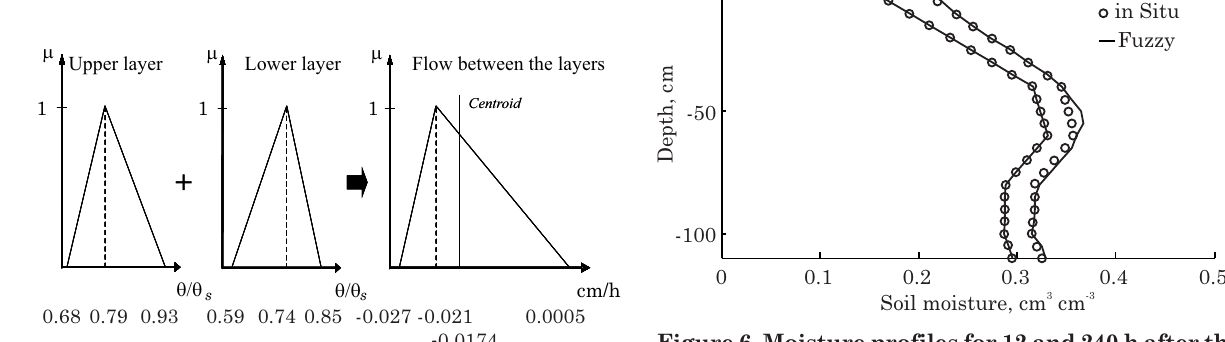
Figure 6. Moisture profiles for 12 and 240 h after the beginning of the simulation. Field data (symbols) and fuzzy rule-based solution (solid